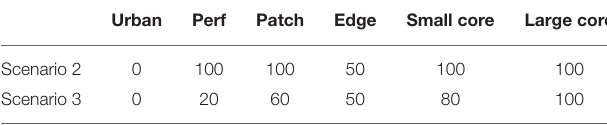
TABLE 1 | Scenarios with different percentages of water infiltration based on capabilities of each fragmentation category to infiltrate rainwater to the aquifer. Urban Perf Patch Edge Small core Large core